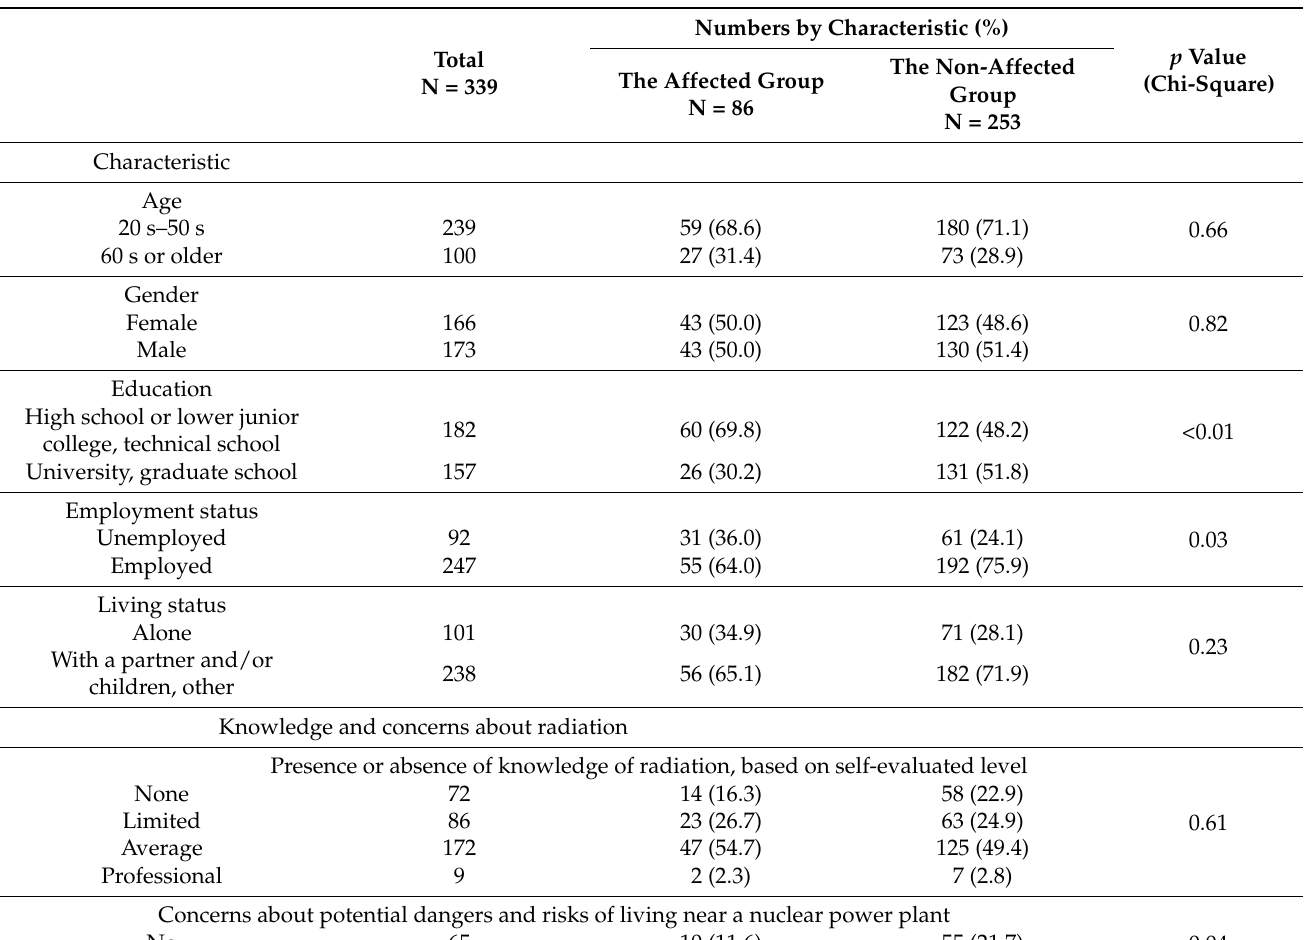
Table 2. Individual characteristics of two residential groups, affected and not affected by the FDNPS accident.